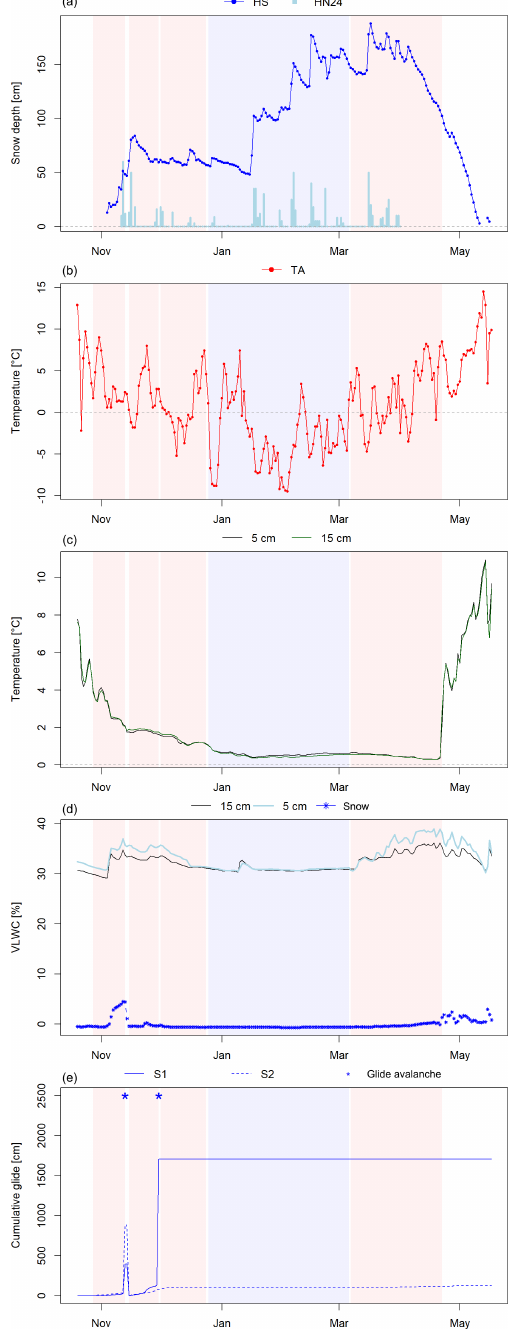
Figure 6. Site Pista Nera, winter season 2014–2015: (a) snow depth (HS) from AWS Weissmatten and new snow sum (HN24) from manual snow measuring site Gabiet, (b) air temperature (TA) from AWS Weissmatten, (c) soil temperature, (d) VLWC measured within the soil and in the basal snowpack layer, (e) cumulative glide. Warm and cold periods are highlighted in orange and blue, respec- tively; periods reported in white are periods of no data analyses for S1, S2 or both (see Table 1 for details) (the period 9–12 Novem- ber 2014 has no analyses for S1). In periods of no analyses the data registered by the WCR probe in the basal snowpack layer might show unrealistic values.